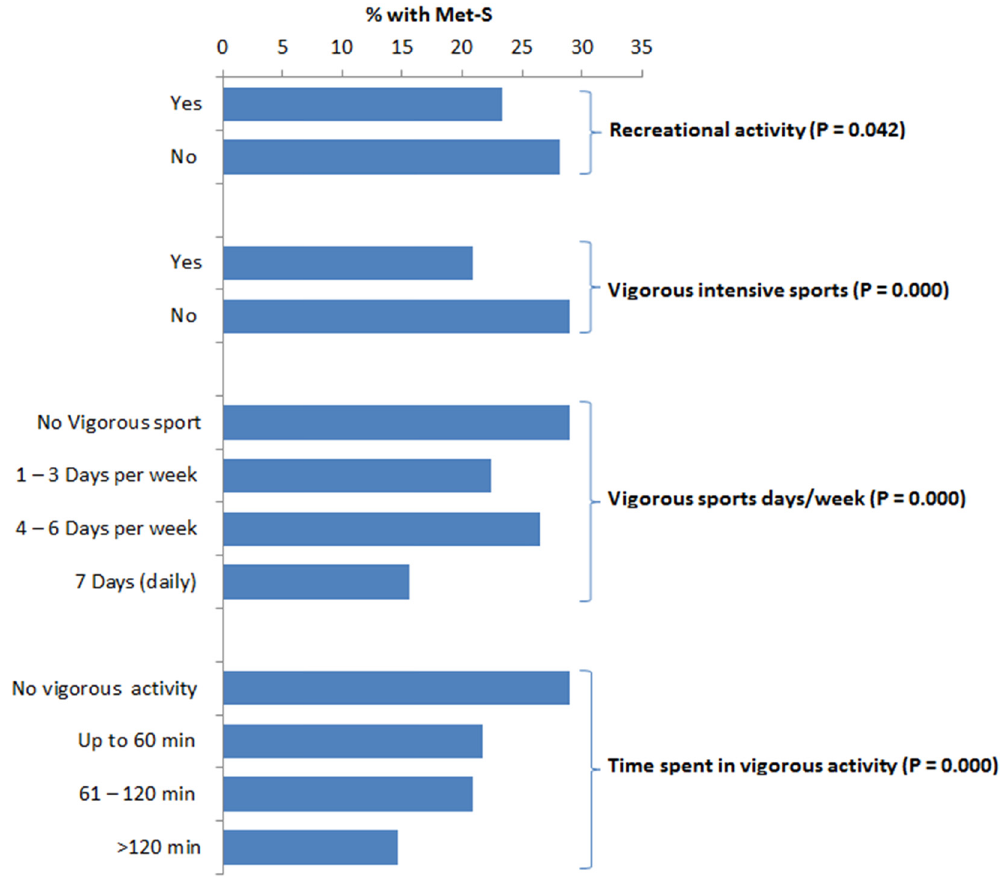
Figure 2: Association between vigorous intensive sports and Met - S. Values are percentage frequency of Met - S in the same